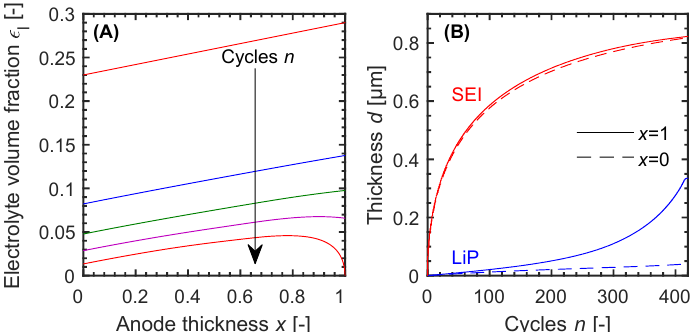
Figure 8. Results for the cell with linearly increasing initial anode porosity. ( A ) Electrolyte volume fraction across the thickness of the anode after n = 0, 100, 200, 300 and 420 cycles. ( B ) Equivalent thickness of the surface layer at the current collector ( x = 0, dashed) and the separator side ( x = 1,